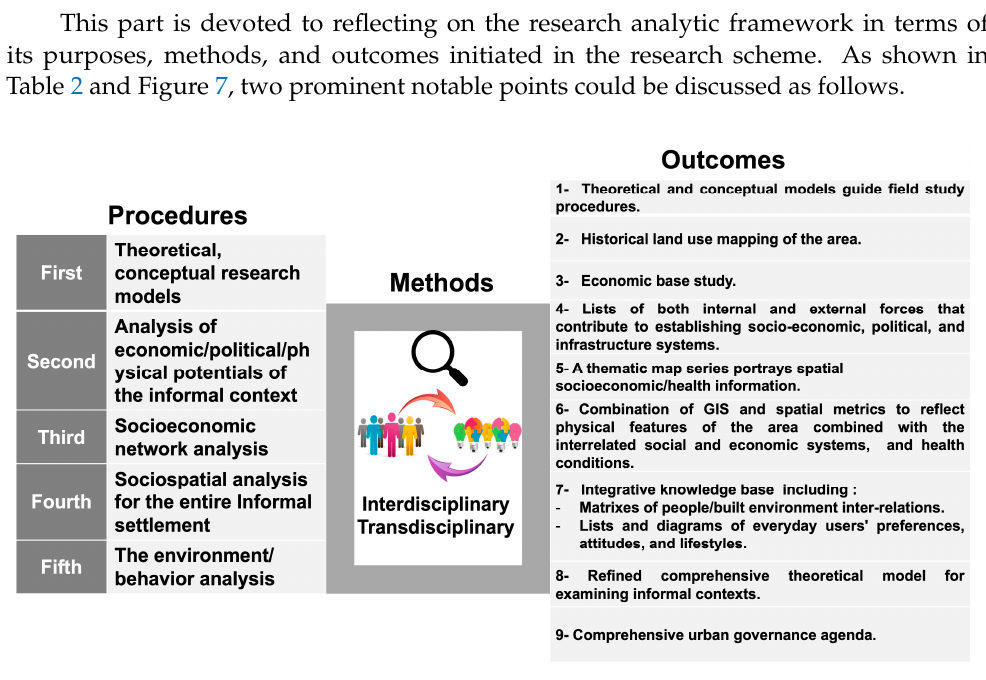
Figure 7. Procedures, methods, and outcomes of the research schema.